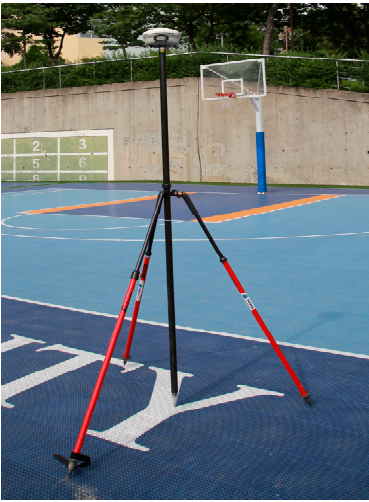
Figure 4. Static GNSS observation conducted for georeferencing of terrestrial laser scanning data.